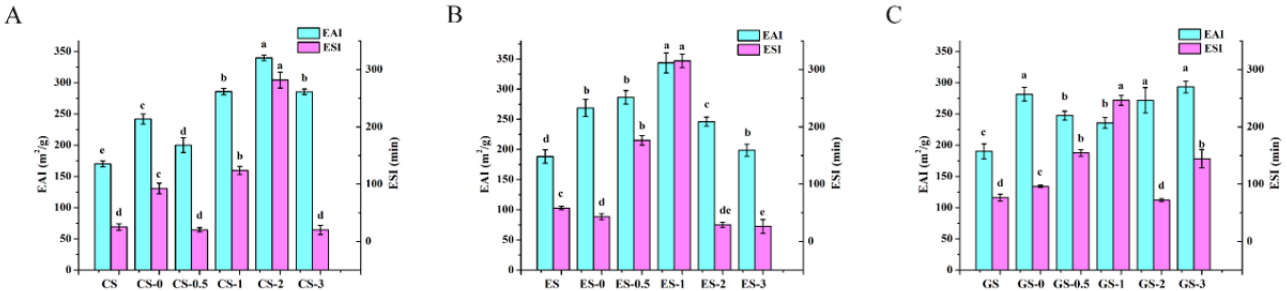
Figure 6. Emulsification activity index and emulsion stability index of fish gelatin. ( A ) CS, CS-0, CS- 0.5, CS-1, CS-2, CS-3: CS gelatin, CS gelatin phosphorylated by STMP for 0, 0.5, 1, 2 and 3 h,